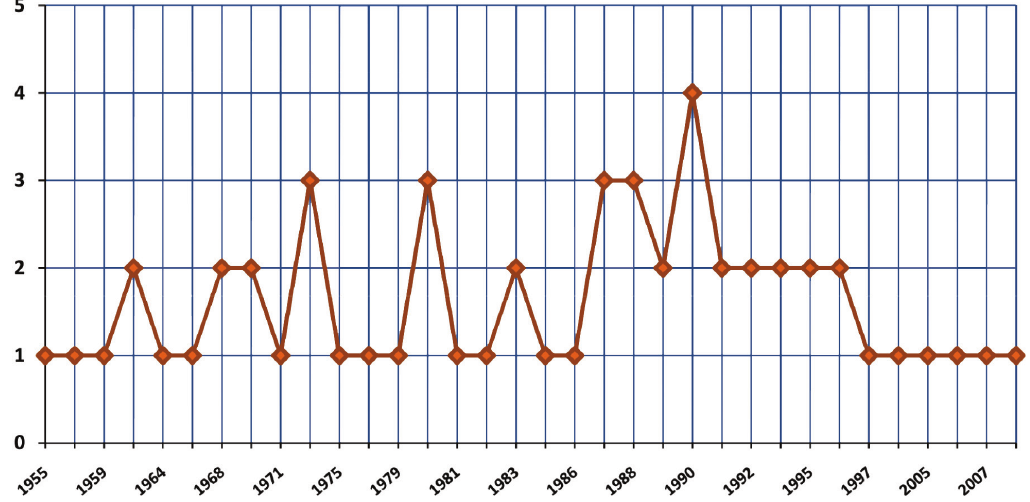
Fig. 2. Construction date of each building inspected (total of 55